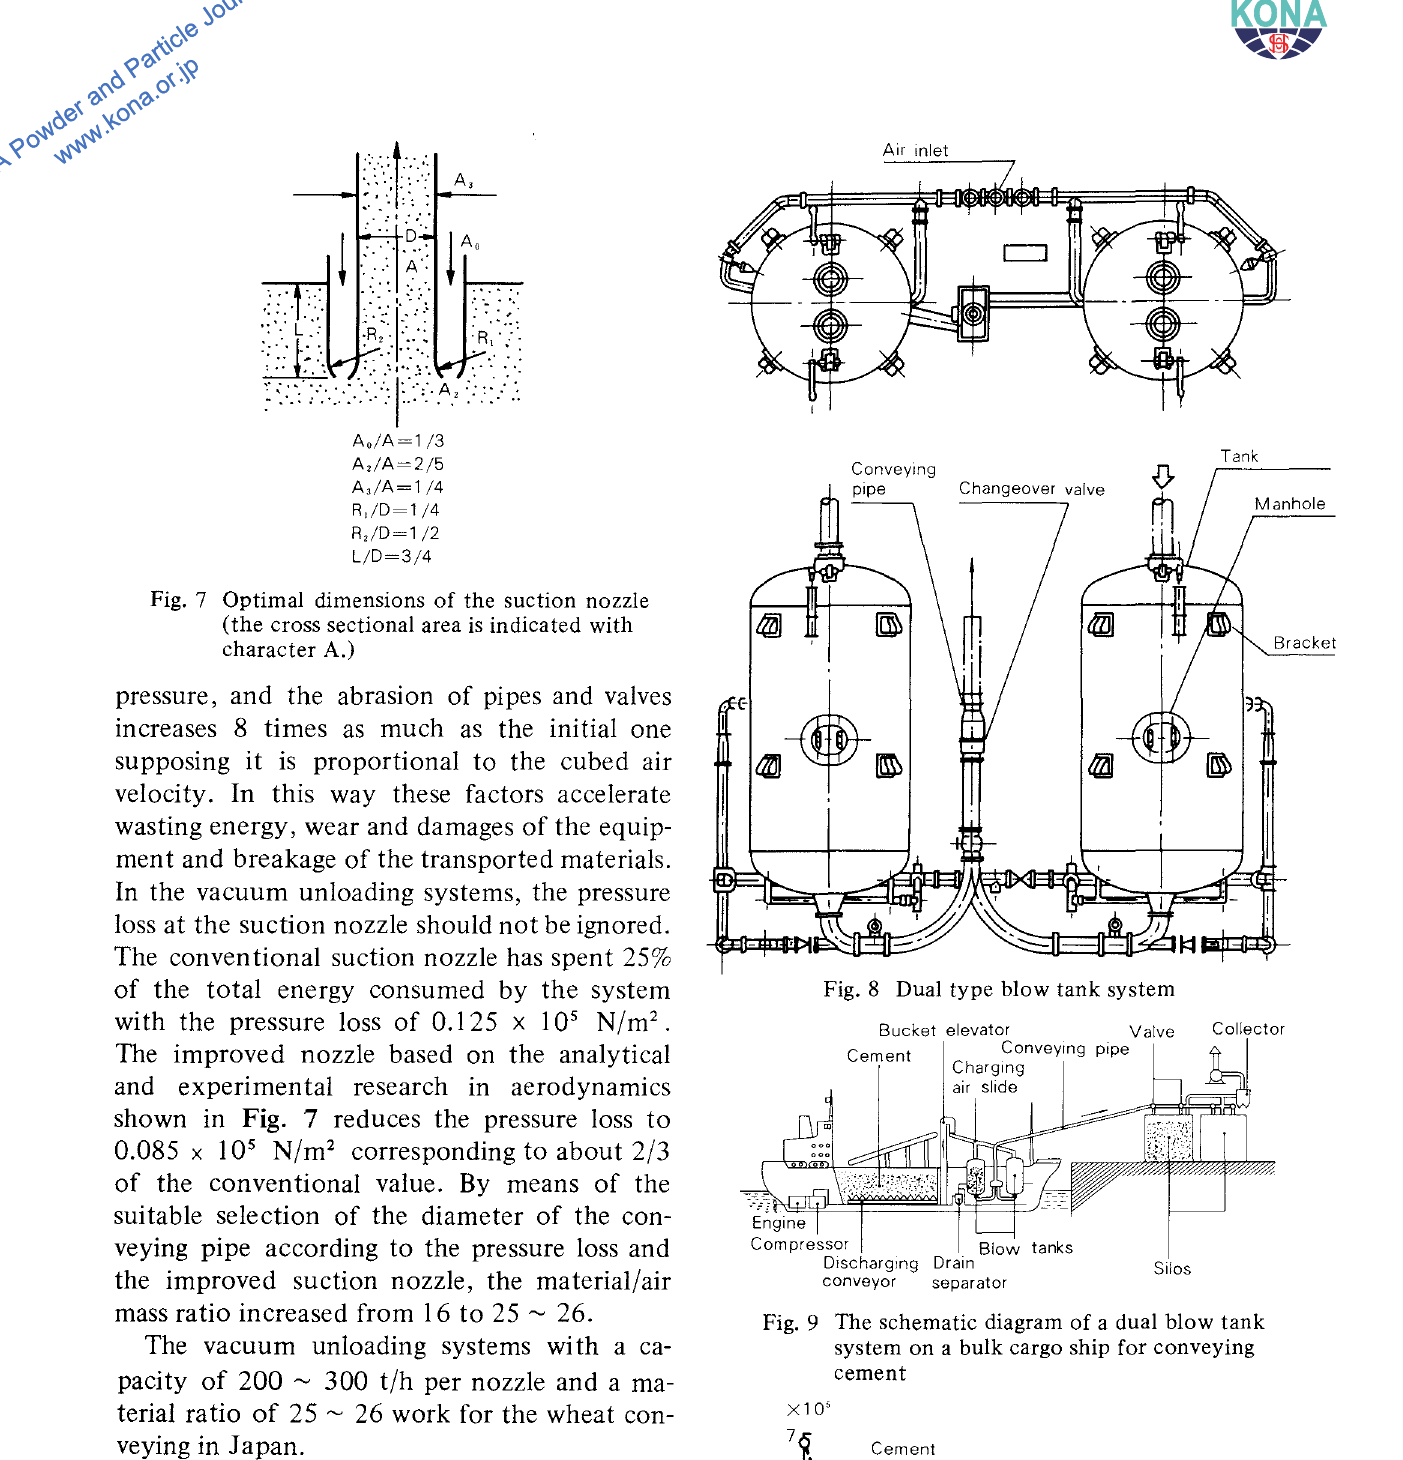
Fig. 7 Optimal dimensions of the suction nozzle (the cross sectional area is indicated with character A.)